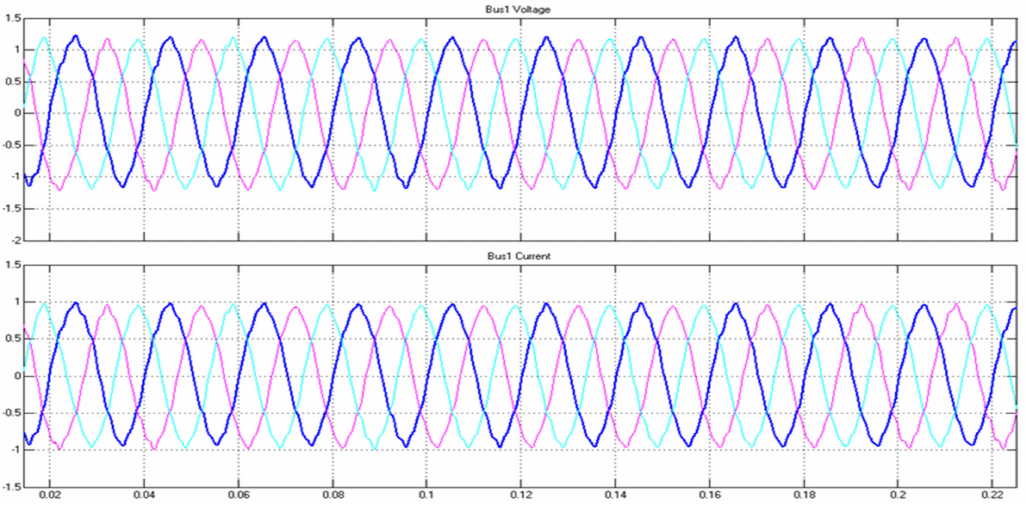
Figure 12. Output waveforms from PMSG.